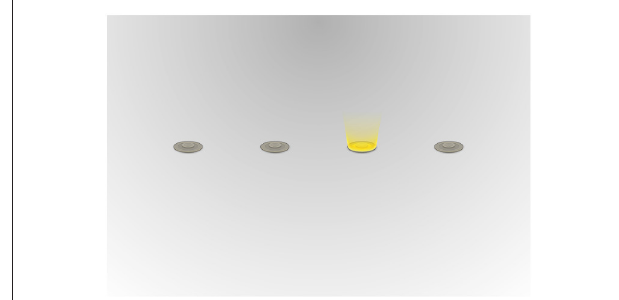
bold black horizontal line. Before each trial, the starting value of the workforce counter was randomized.